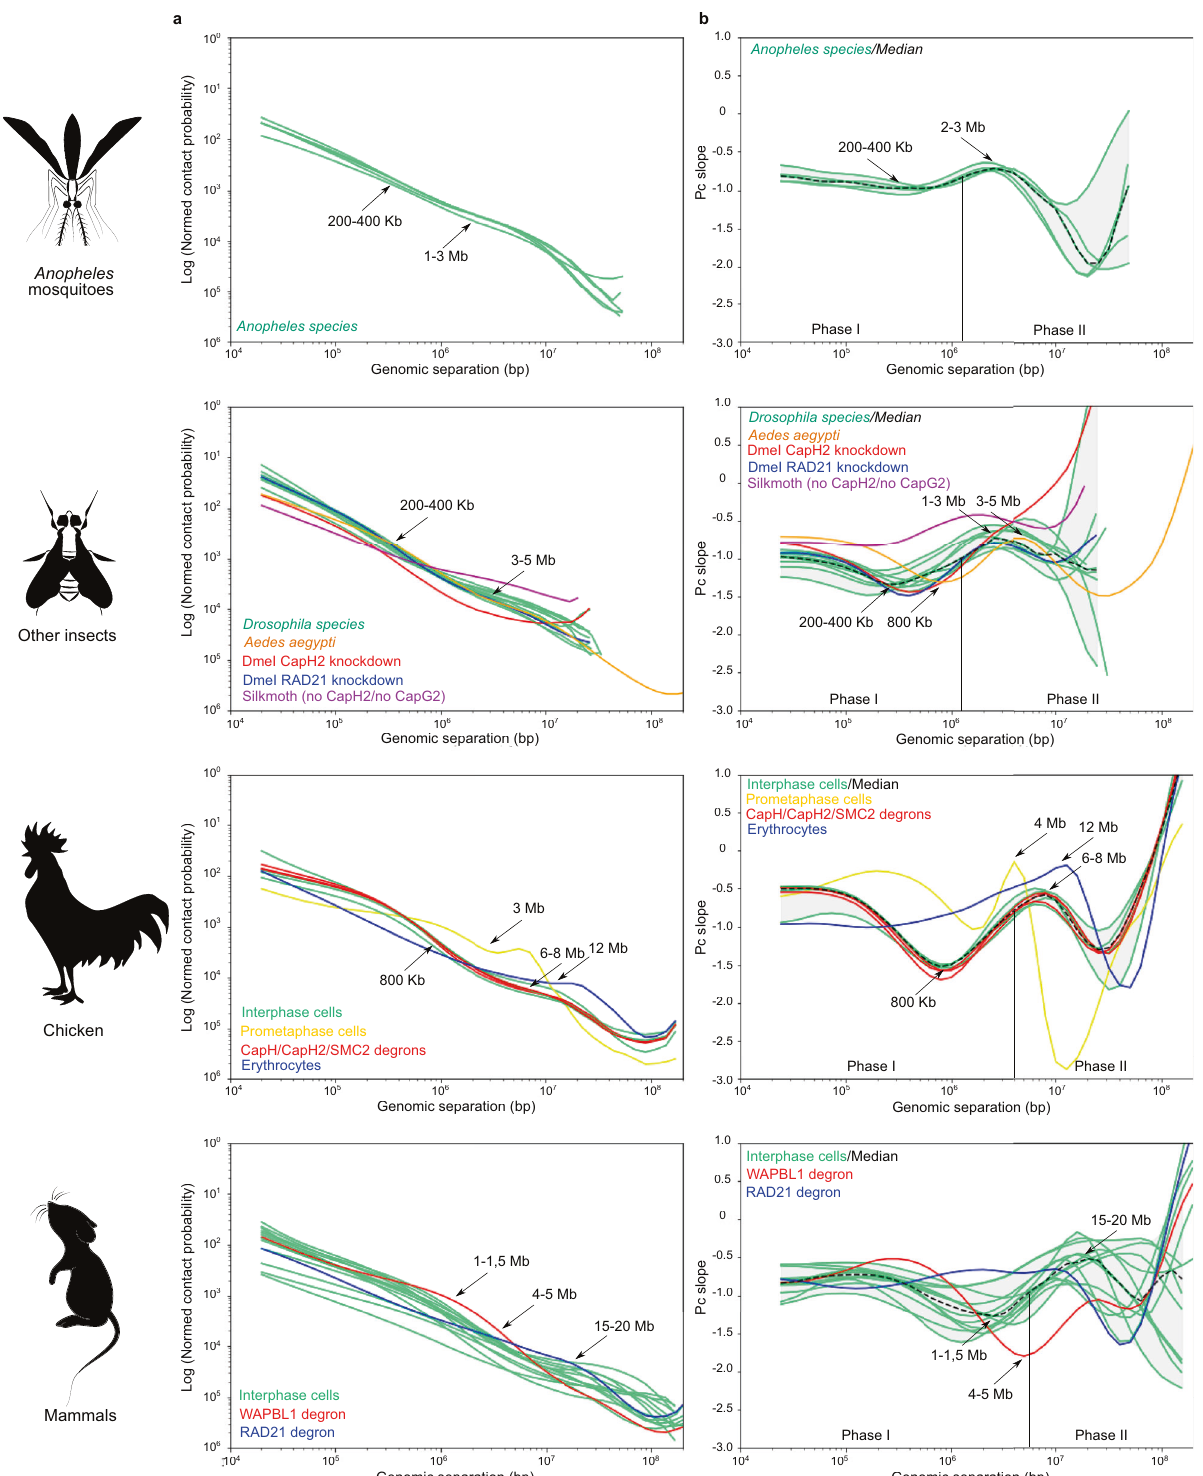
Fig. 10 Contact frequency decays non-uniformly with genomic distance. a Dependence of contact probability on genomic distance for Anopheles , other insects, chicken, and mammals shown in log – log coordinates; b Slope of the curve depicted in a , as a function of genomic distance. Black dashed line shows the median, and the gray area represents minimal and maximal values for several species. Slope-plots for individual species are shown as thin green lines. intercalary heterochromatin blocks showed interaction patterns cytogenetically de fi ned as diffuse intercalary heterochromatin 42 , distinct from other B-compartment regions. Our work identi fi ed at form B-compartments with regions of pericentromeric hetero- least two types of B compartments in mosquitoes: euchromatic chromatin, but they do not form B-compartments with euchromatic and heterochromatic. Large intercalary heterochromatin blocks, regions. Euchromatic regions form their own B-compartments, NATURE COMMUNICATIONS| (2022) 13:1960